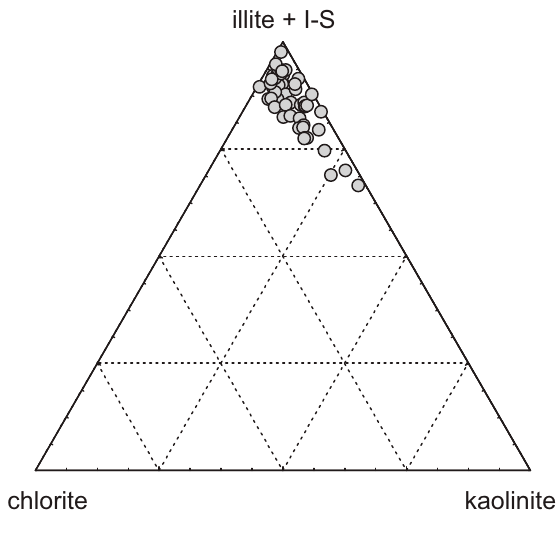
Fig. 3. Triangular diagram showing the semi­quantitative clay mineral composition of the <2 µm fraction of the Cambrian Blue Clay in the northern Baltic Palaeobasin.